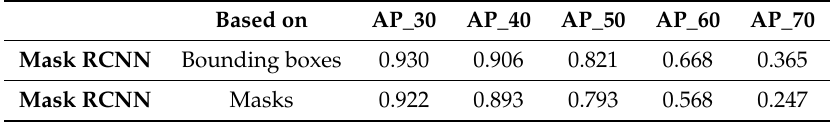
Table 2. The mean Average precision is given for different IoU thresholds based on detected bounding boxes or detected